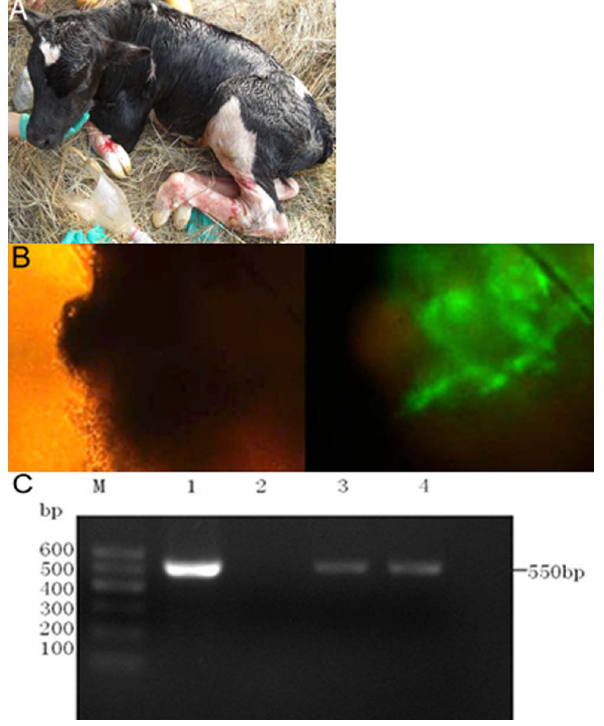
Figure 5. Detection of hIFN- a expression in the transgenic SCNT calf by PCR and GFP expression by fluorescence microscopy. (A) Live-born transgenic calf. (B) GFP expressed in ear skin from the transgenic SCNT calf that died at two days of age under light microscopy ( 6 40) and under fluorescence microscopy ( 6 40). Green: GFP. (C) PCR analysis of the hIFN- a gene expressed in the transgenic SCNT calf that died at two days of age. Lane M, 100 bp molecular weight marker; lane 1, pIRSEneo- IFN -bCP- LFCIN B - EGFP as template; lane 2, DNA from the wild-type calf as a template; lane 3, blood from the transgenic SCNT calf; lane 4, funiculus umbilicalis